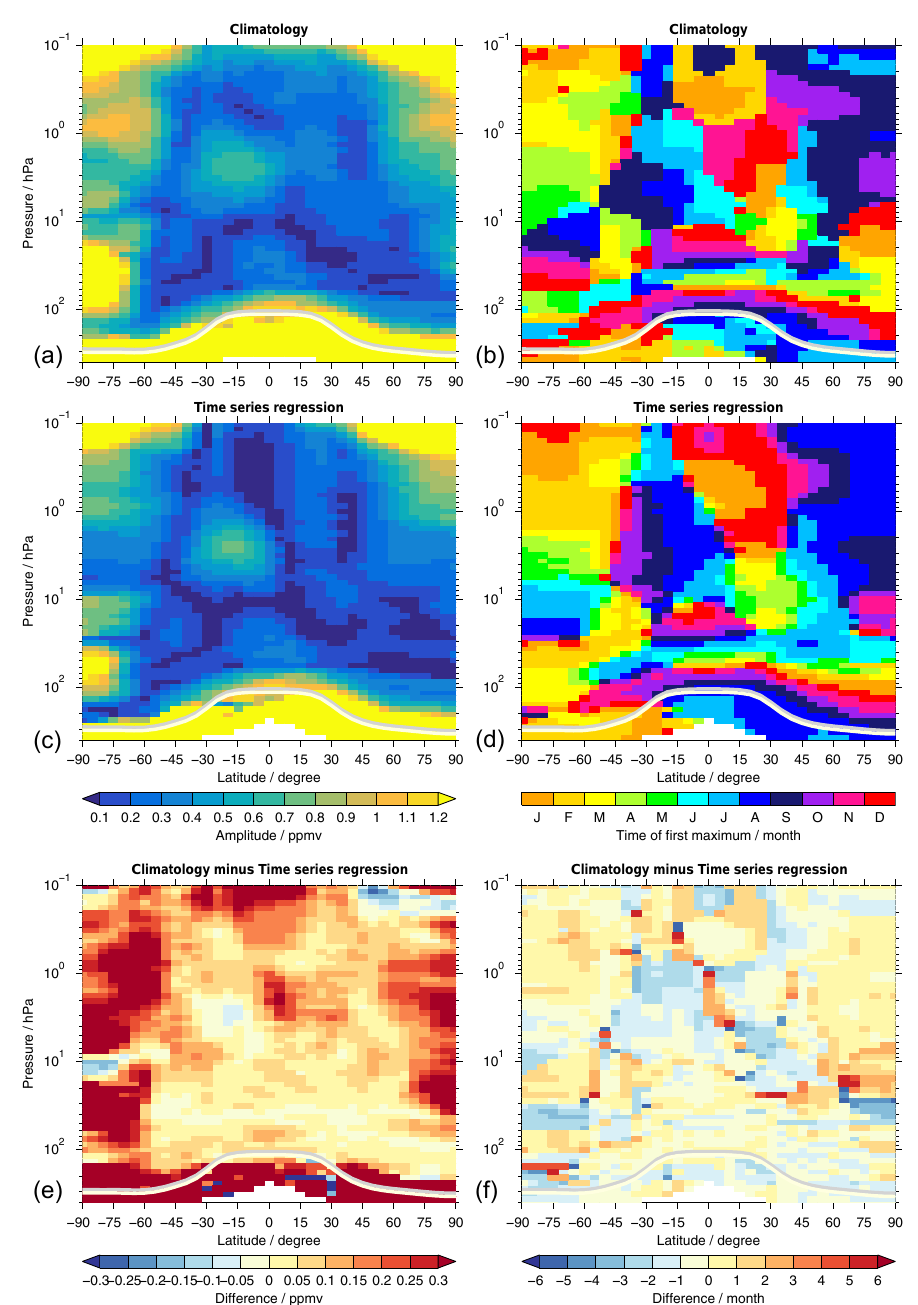
Figure 15. Comparison of amplitude and phase for the annual variation as derived with the climatology approach (top row; see Sect. 5.3) and the time series regression approach (middle row; see Sect. 3.2). The bottom row shows the differences between the two approaches. This example is based on results of the MIPAS-ESA V5R NOM data